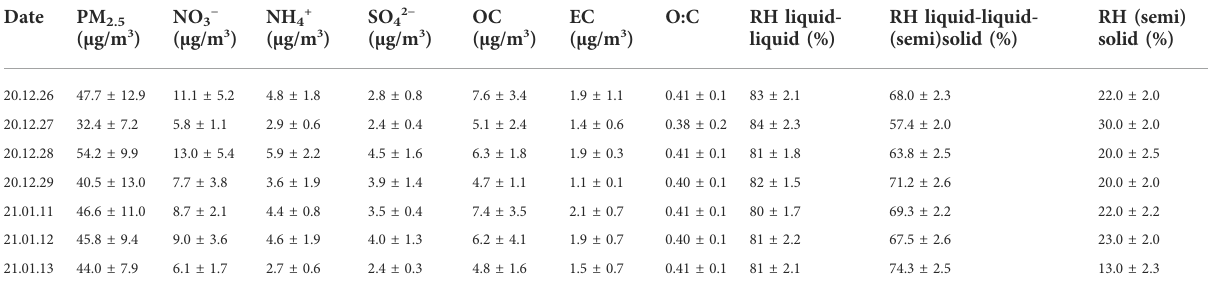
TABLE 1 Summary of the chemical compositions, oxygen-to-carbon elemental ratio (O:C), and relative humidity (RH) in liquid-liquid, liquid-liquid- (semi)solid, and (semi)solid phase states of PM 2.5 with decreasing RH based on the interval of fi lter sampling.